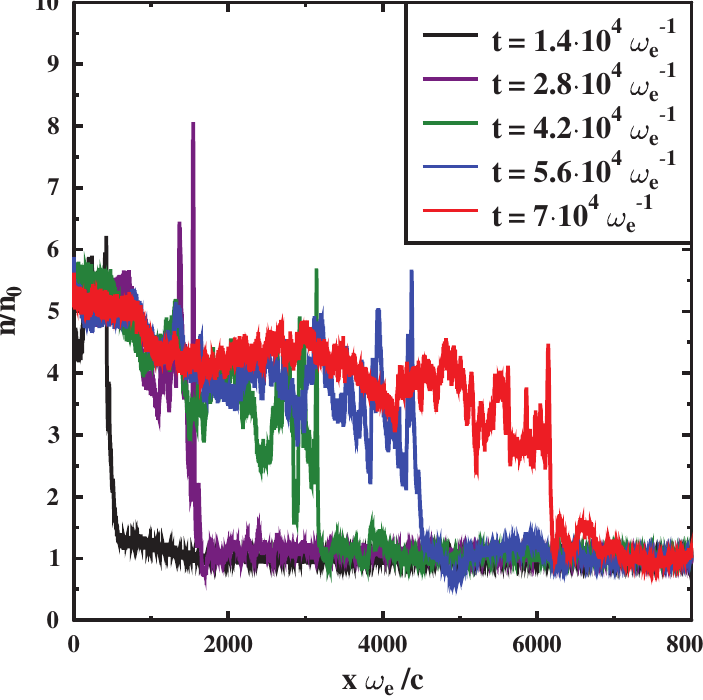
Figure 2. Time evolution of concentration normalized to the far upstream